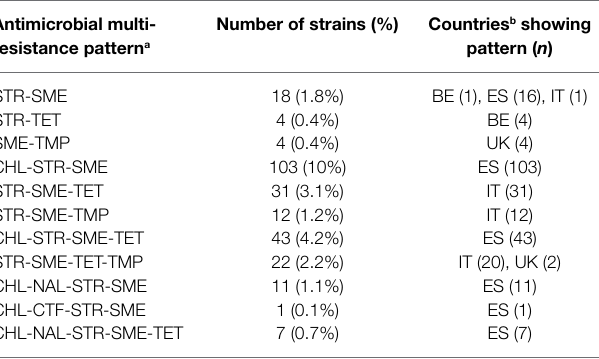
TABLE 3 | Antimicrobial multi-resistance patterns of porcine Yersinia enterocolitica 4/O:3 strains. Antimicrobial multi- resistance pattern